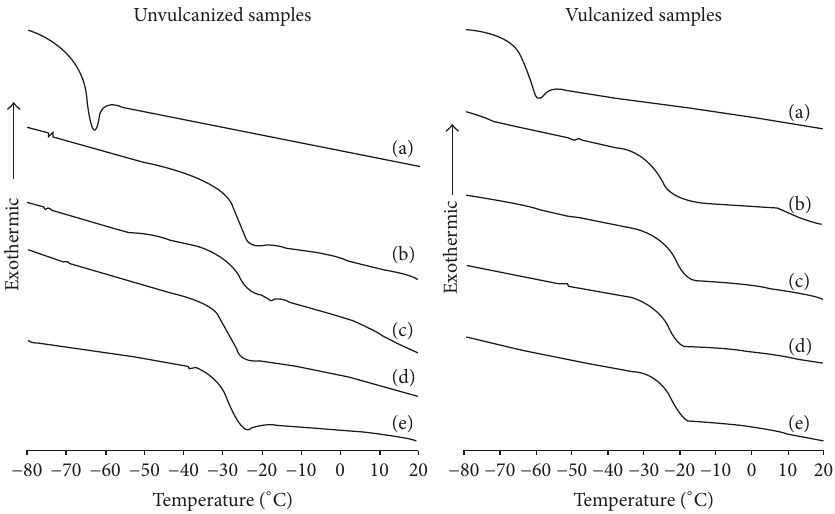
Figure 3: DSC thermograms derived from the second heating scan of (a) NR, (b) ENR 40, and nanocomposites of (c) 100/1 ENR 40/nSiO 2 , (d) 100/2 ENR 40/nSiO 2 , and (e) 100/3 ENR 40/nSiO 2 . Table 1: Thermal properties of NR, ENR 40, and ENR 40/nSiO 2 nanocomposites obtained from DSC, DMA, and TGA analyses. Thermal